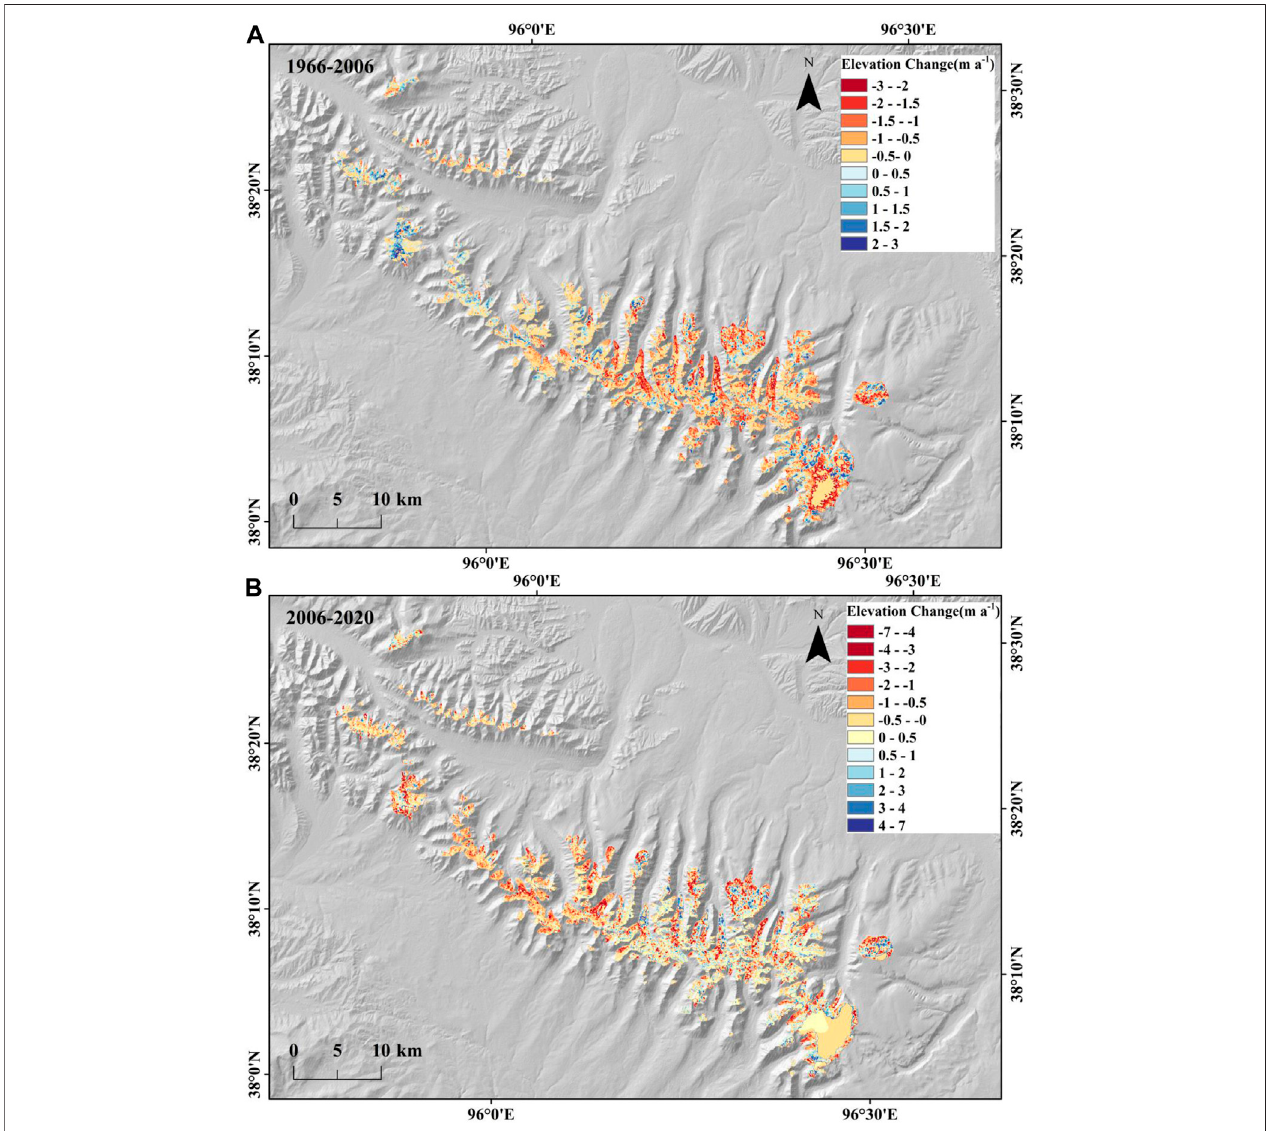
FIGURE 3 | Surface elevation changes of glaciers over the Turgen Daban Range between 1966 and 2006 (A) and from 2006 to 2020 (B) .